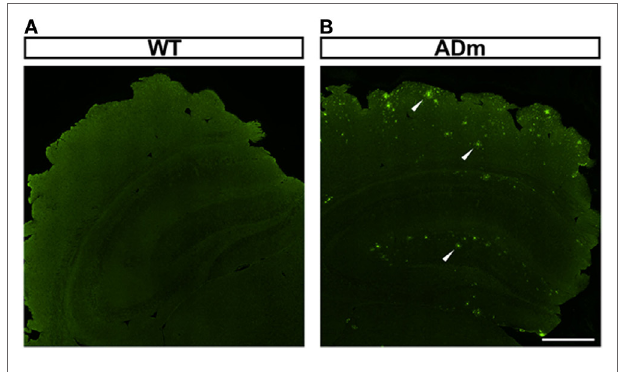
FigUre 1 | Illustrative example of amyloid- β positive plaque deposition. Coronal sections of paraffin-embedded brains from WT (a) and ADm (B) mice were stained using clone 4G8 immunosera. White arrowheads highlight the positive amyloid- β plaques deposited throughout the brain in ADm mice. Scale bar 500 µm. WT, wild type; ADm, Alzheimer’s disease transgenic